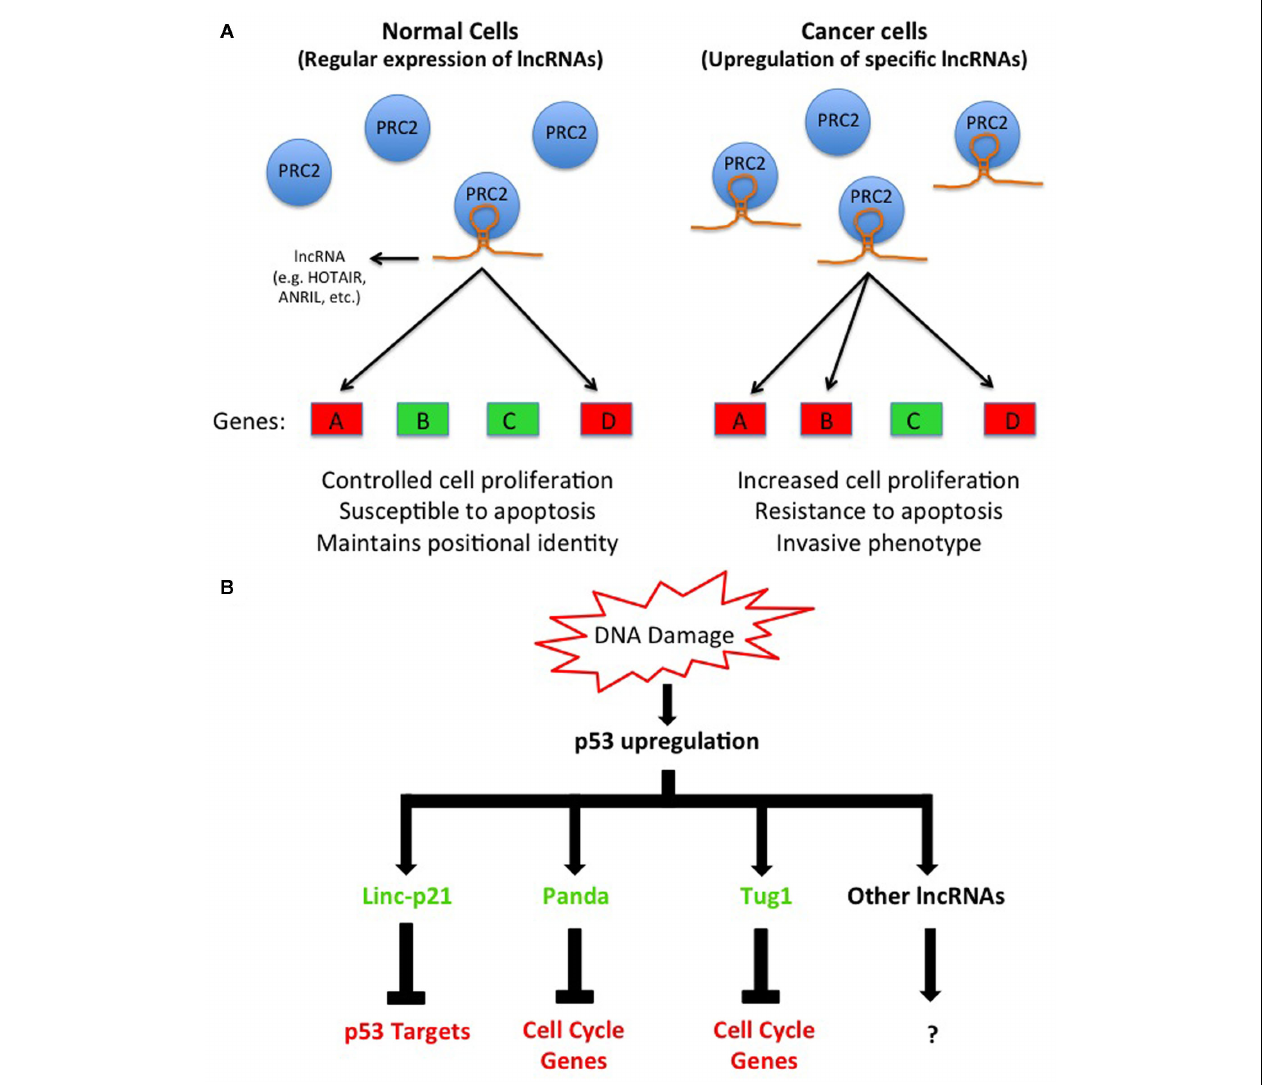
one or more tumor suppressor genes leads to their repression; and consequently affects cells ability to regulate their normal proliferation pattern or induce apoptosis. Conversely, an upregulated lncRNA that leads an activating chromatin-modifying complex to oncogenes may also perturb normal cellular functions (not shown). (B) A group of lncRNAs is known to be induced directly by p53, which can be activated by various stimuli including DNA damage.These lncRNAs, once activated, modulate gene expression by a variety of mechanisms via their protein